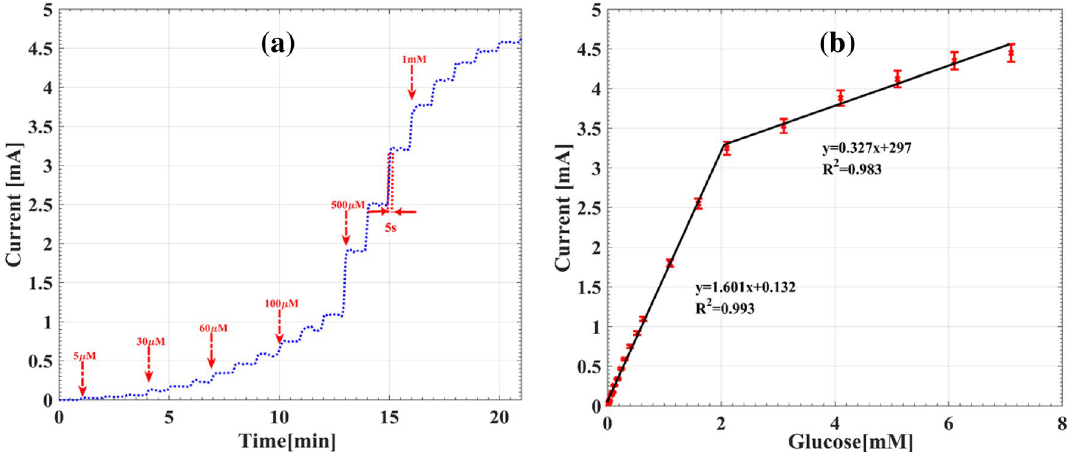
Figure 6. ( a ) Amprometric response of the Au@Cu 2 O electrode after successive addition of glucose into 0.1 M NaOH. ( b ) The current response versus glucose concentration for this electrode. Reference Linear range Electrode Potential (V) electrode